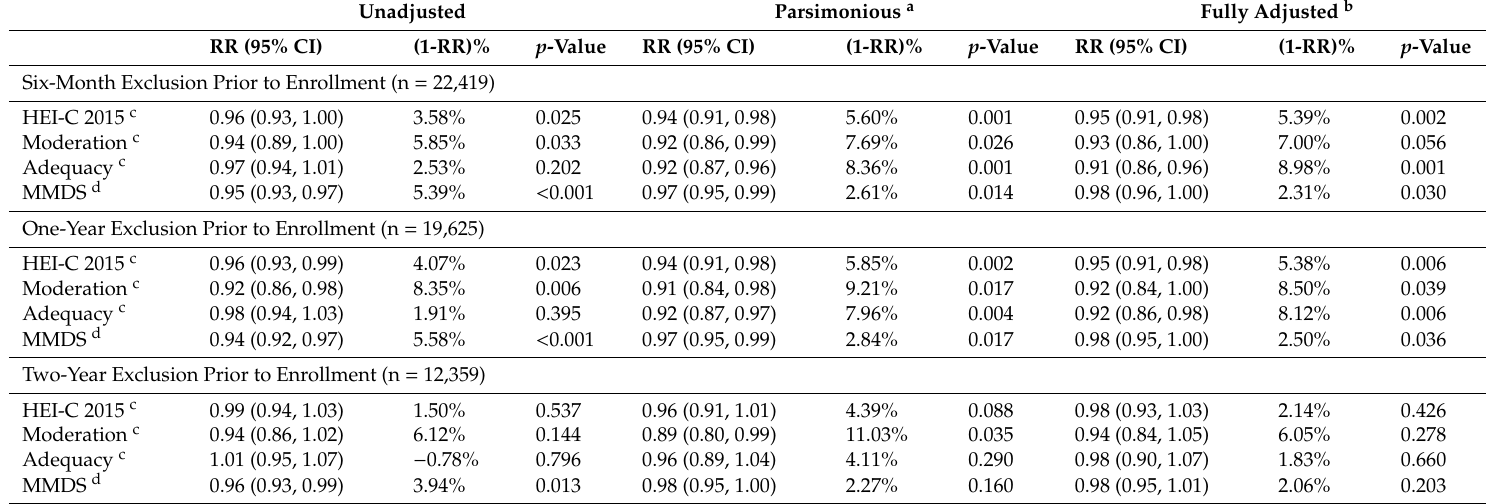
Table 4. Associations of increases in HEI-C 2015 and MMDS scores with number of physician visits for depression following exclusions. Unadjusted Parsimonious a Fully Adjusted